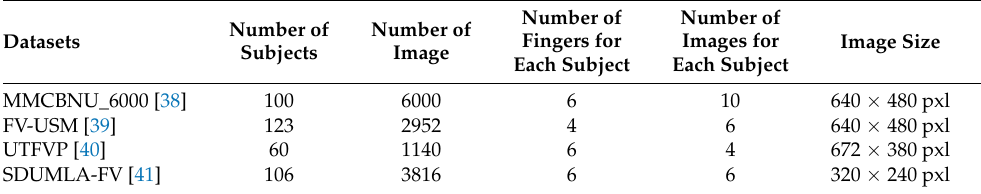
Table 1. Details of the experimental